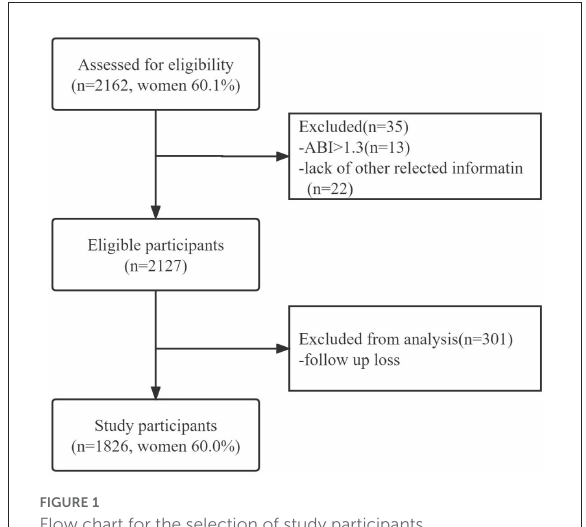
FIGURE1 Flow chart for the selection of study